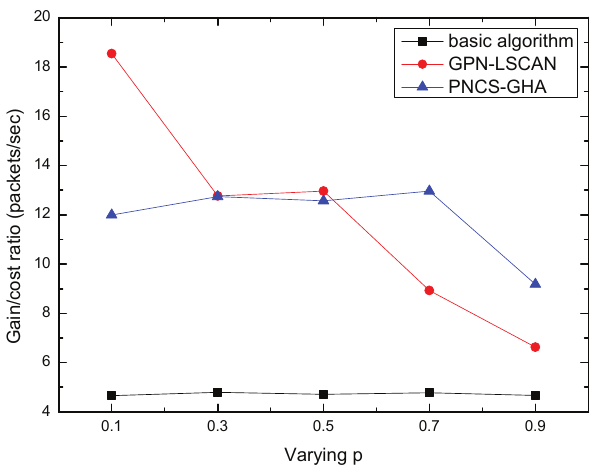
Figure 8. Average gain to cost ratio VS p